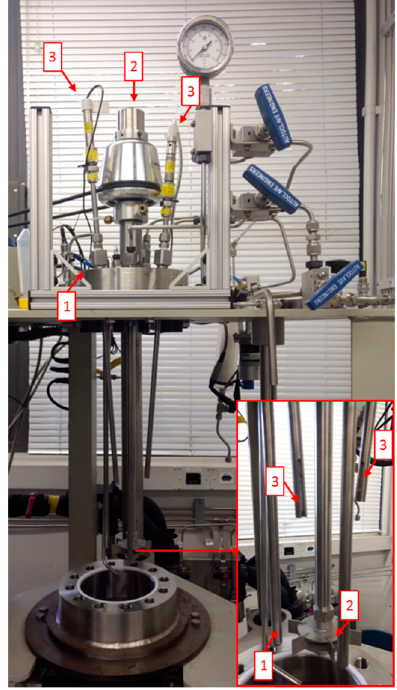
Figure 3. Internal of the 10 L reactor showing the described features of the system. (1) Type T thermocouple; (2) stirrer; and (3) pH probes.